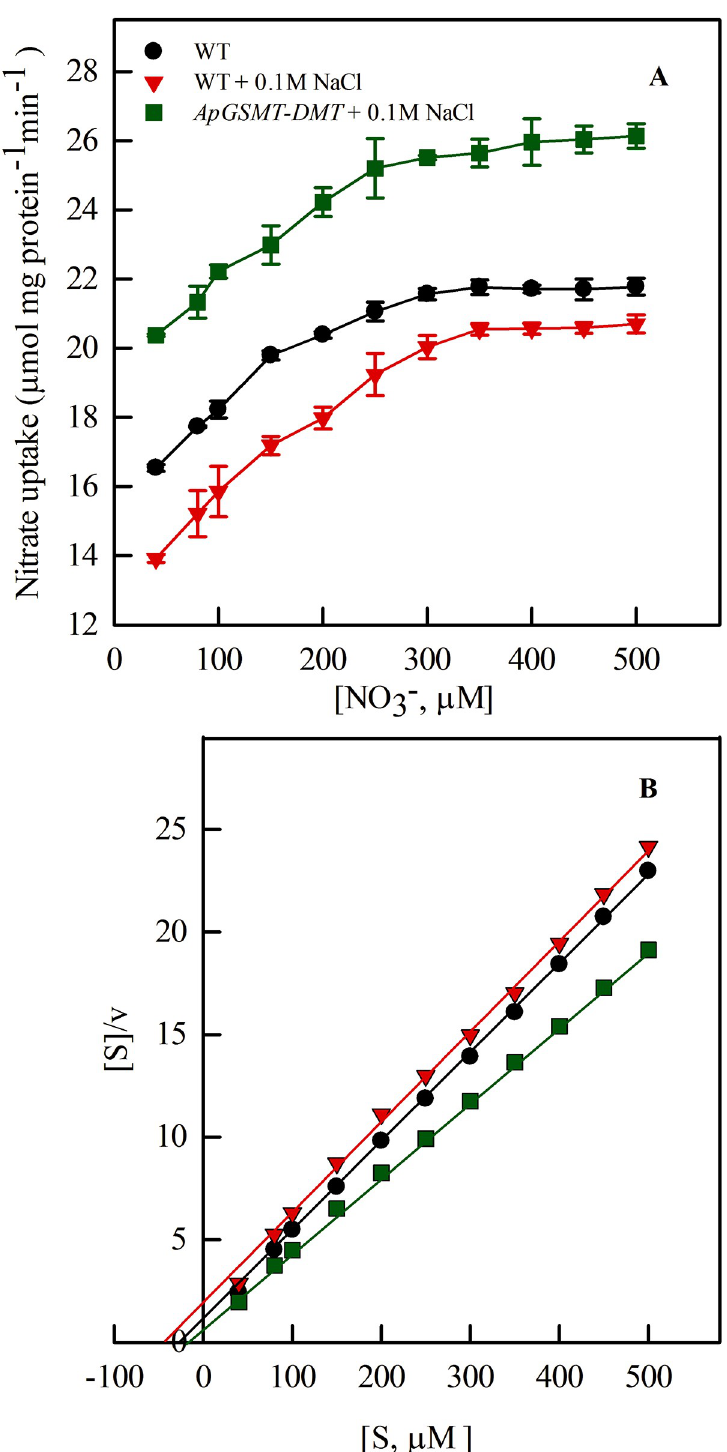
Fig 2. Nitrate uptake in Anabaena 7120, WT and ApGSMT-DMT transformant. Exponential phase cyanobacterial cells growing on N 2 in the presence and absence of 0.1 M NaCl were collected and suspended in their specific media containing varied concentrations (40–500 μ ) of nitrate. Uptake was performed under standard growth conditions in light (70 μ E m 2 s 1 ). Samples were withdrawn at 10 min of incubation and measured nitrate depletion in the incubation mixture. Values represent means and SDs of triplicate experiments. (A) Initial rate of nitrate transport at different substrate concentrations; (B) Hofstee plot (v versus v/[S]) to determine the kinetics.